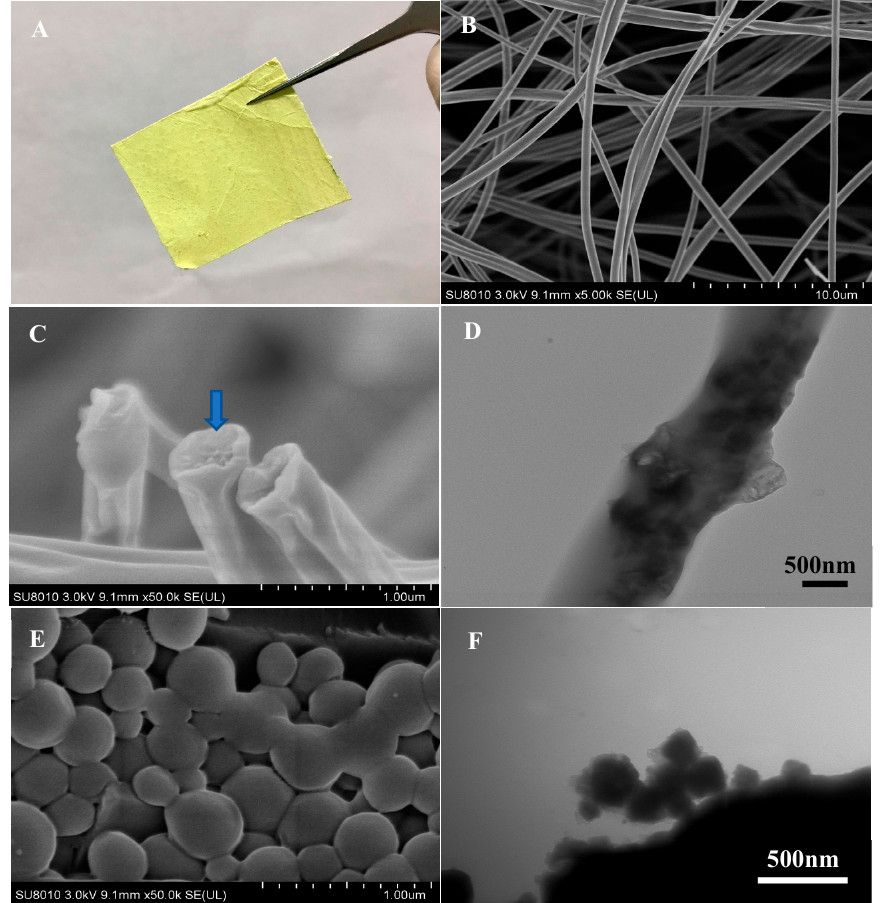
Figure 1. The schematic diagram of Z–Cur NPs assembly and encapsulation in fibermats by co-axial electrospinning and release of Cur.